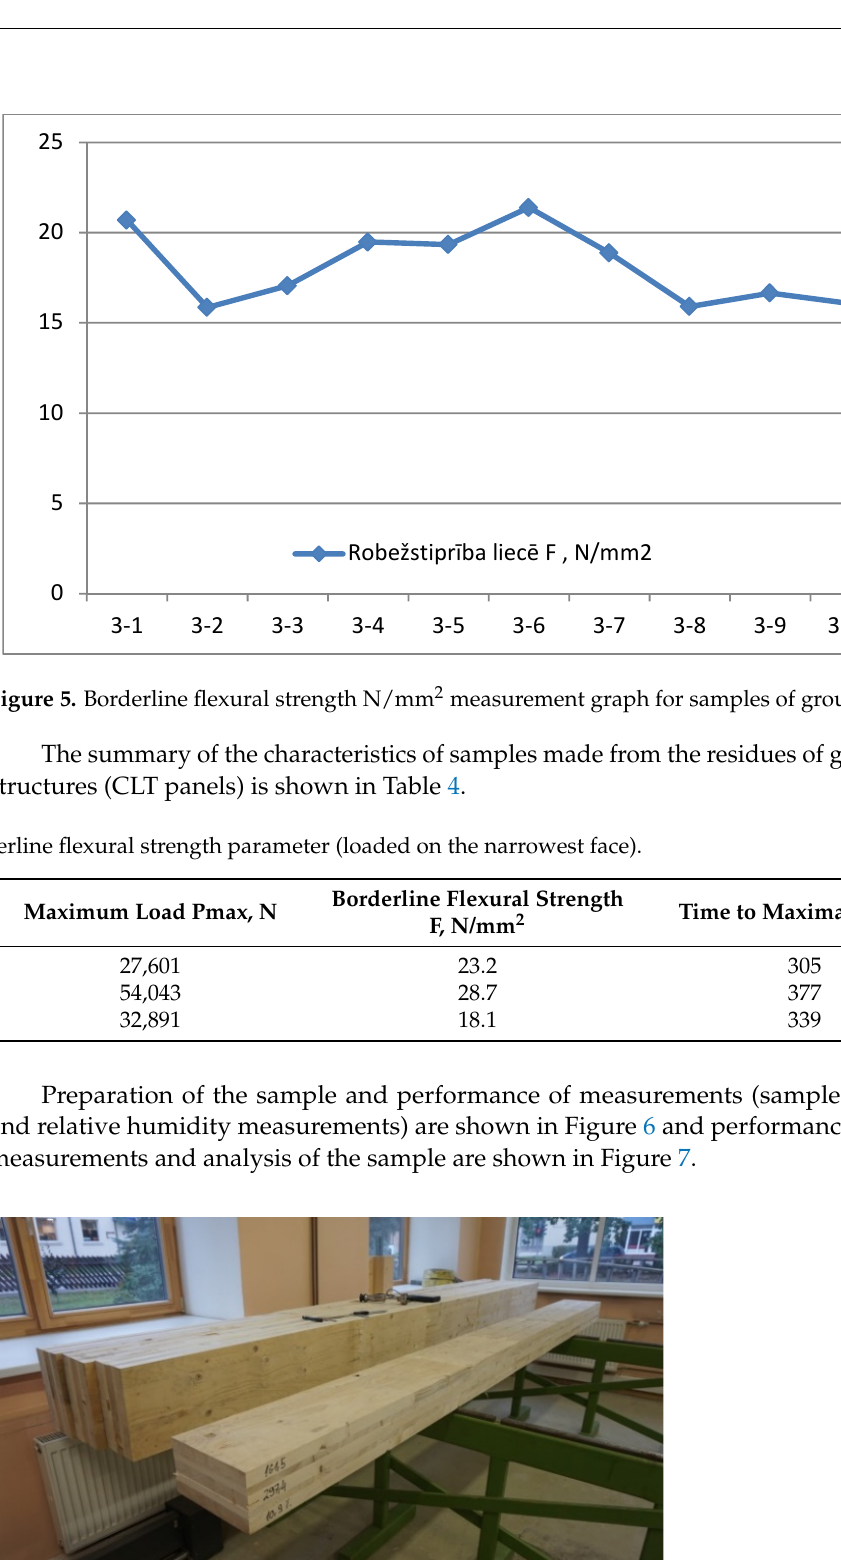
( b ) Figure 7. ( a ) Performance of sample measurements ( b ) Analysis of the sample. 4. Conclusions The results of the study will enable the optimisation of the manufacturing process by reprocessing the residues arising during CLT processing into material suitable for the production of large constructions, thus ensuring economic use of the material as well as manufacturing efficiency. The created device with a semi-automatic finger joint insertion method is a unique device that will enable a considerable increase in the development of CLT panels and reduce the cost of panels. Nevertheless, it must be considered that time is required to improve the operation and efficiency of the device and to ensure stable and precise technical parameters of the production residue of CLT panels. Additional research on the improvement of the application of glue and treatment processes is required. CLT panels are manufactured using 20, 30 and 40 mm boards, which allow one to obtain various standard thicknesses of panels, e.g., 60, 80, 100, 120, 140, 160 mm, etc. Various layers of layers are used for the creation of various thicknesses depending on the necessary technical properties, for example, structural, fire, visual properties or economic aspects. Therefore, residues of CLT panels with similar types of lamellae were selected for testing. The results of measurements of the borderline flexural strength of samples made of CLT panel production residues show that samples of group No. 2 (average dimensions of the sample 161.30 mm × 298.20 mm) reach C 27 requirements of flexural strength (aver-